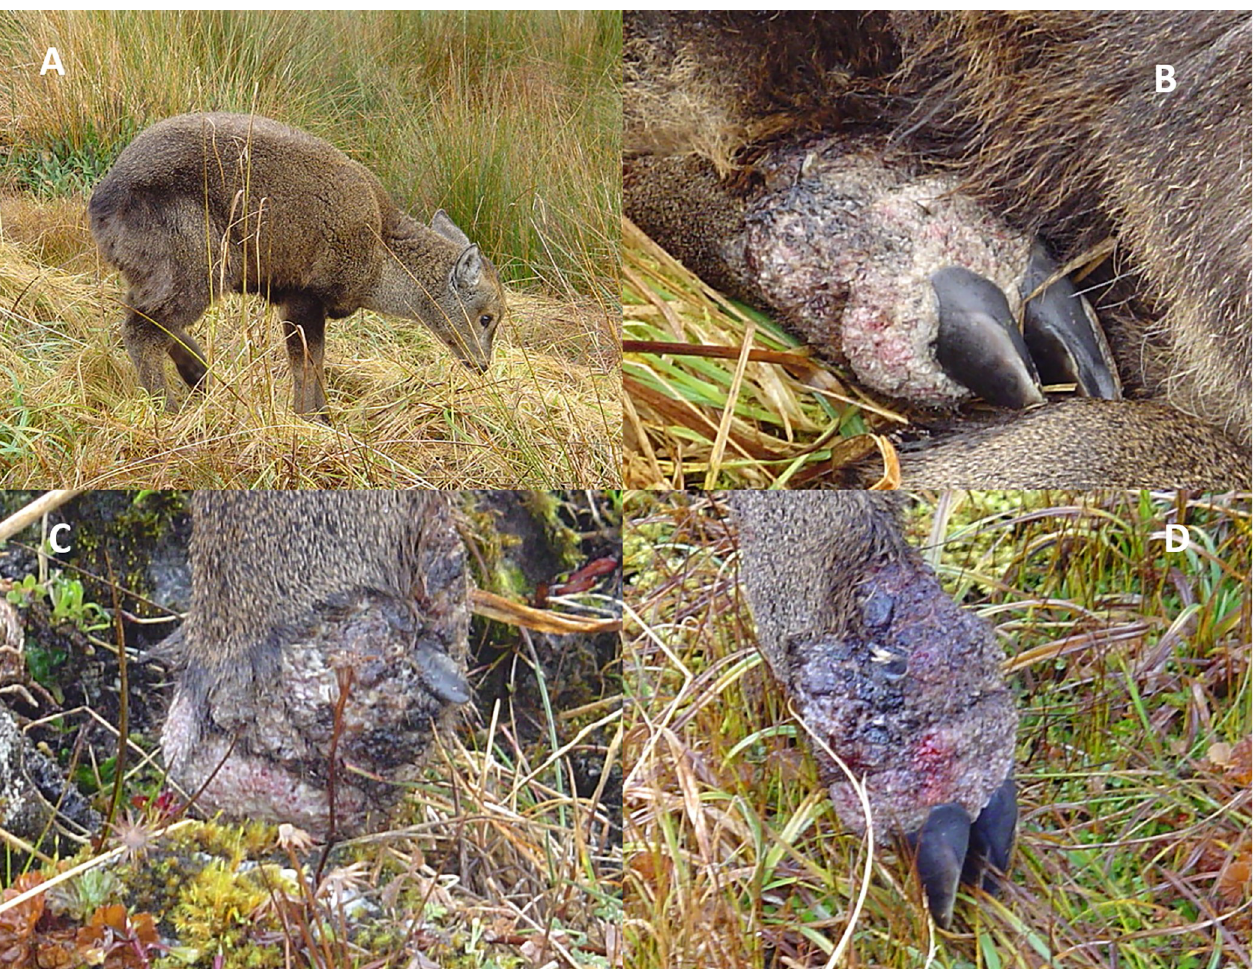
Fig 4. Male huemul fawn case observed in June 2008 (Case #10, Table 1). A) Both left limbs are severely affected. The fawn supported the bulk of its weight on its right limbs, suggestive of pain in the left limbs. B) Close-up of rear left foot. C) Close-up of front foot. D) Close-up of foot and